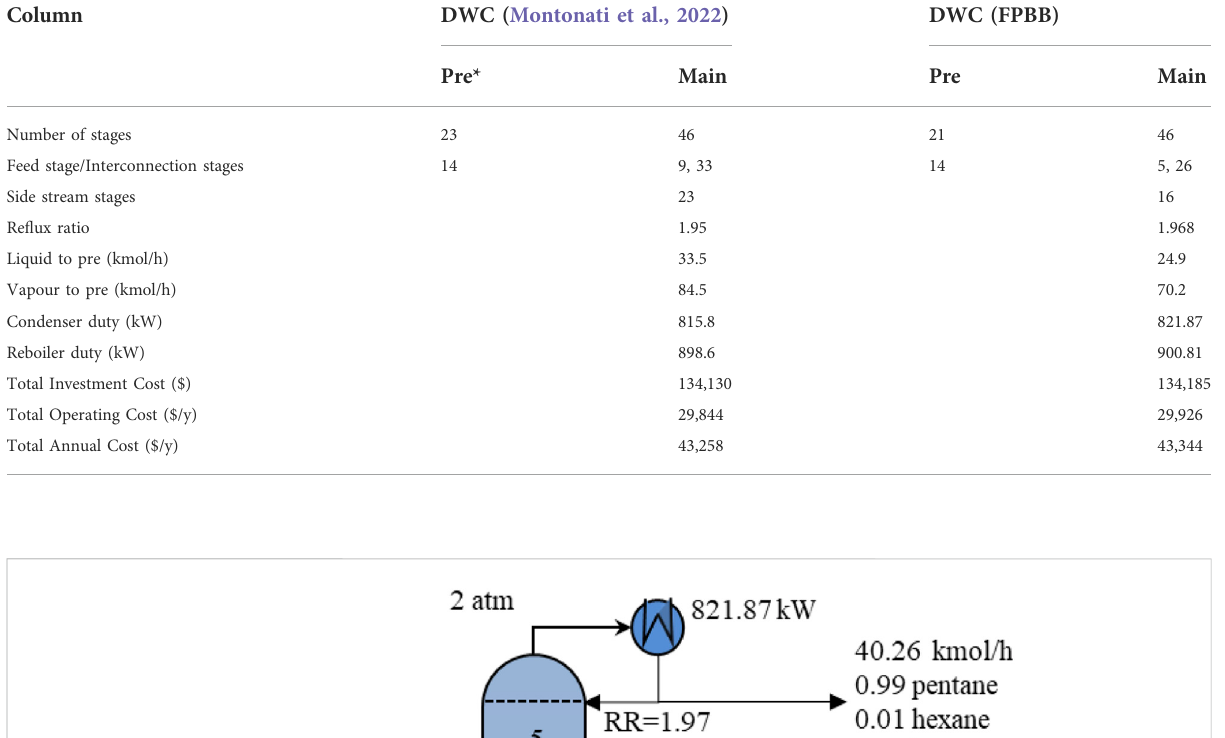
TABLE 2 Optimal design for Example 1.